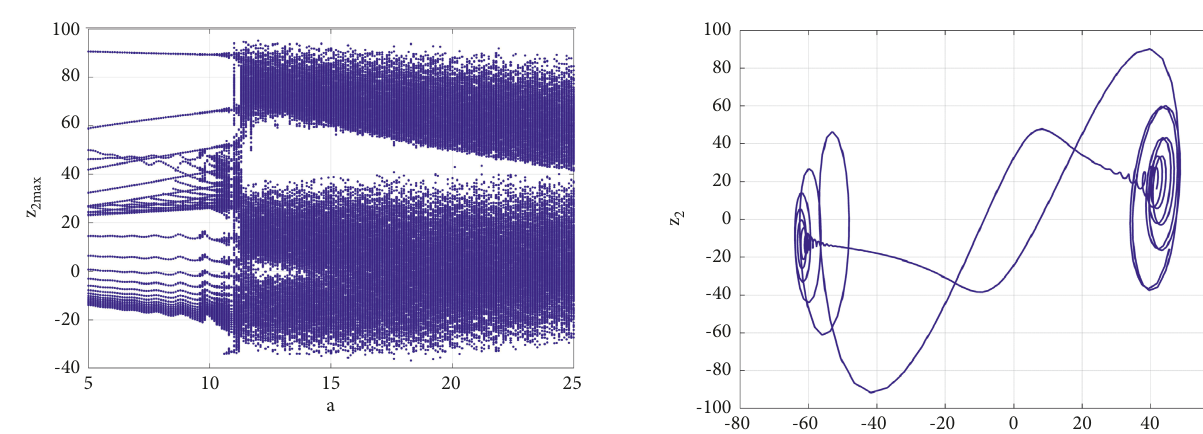
Figure 2: Bifurcation diagram for the model (1) when a varies in [ 5 , 25 ] and ( b, c, d ) � ( 8 , 90 , 6 ) .